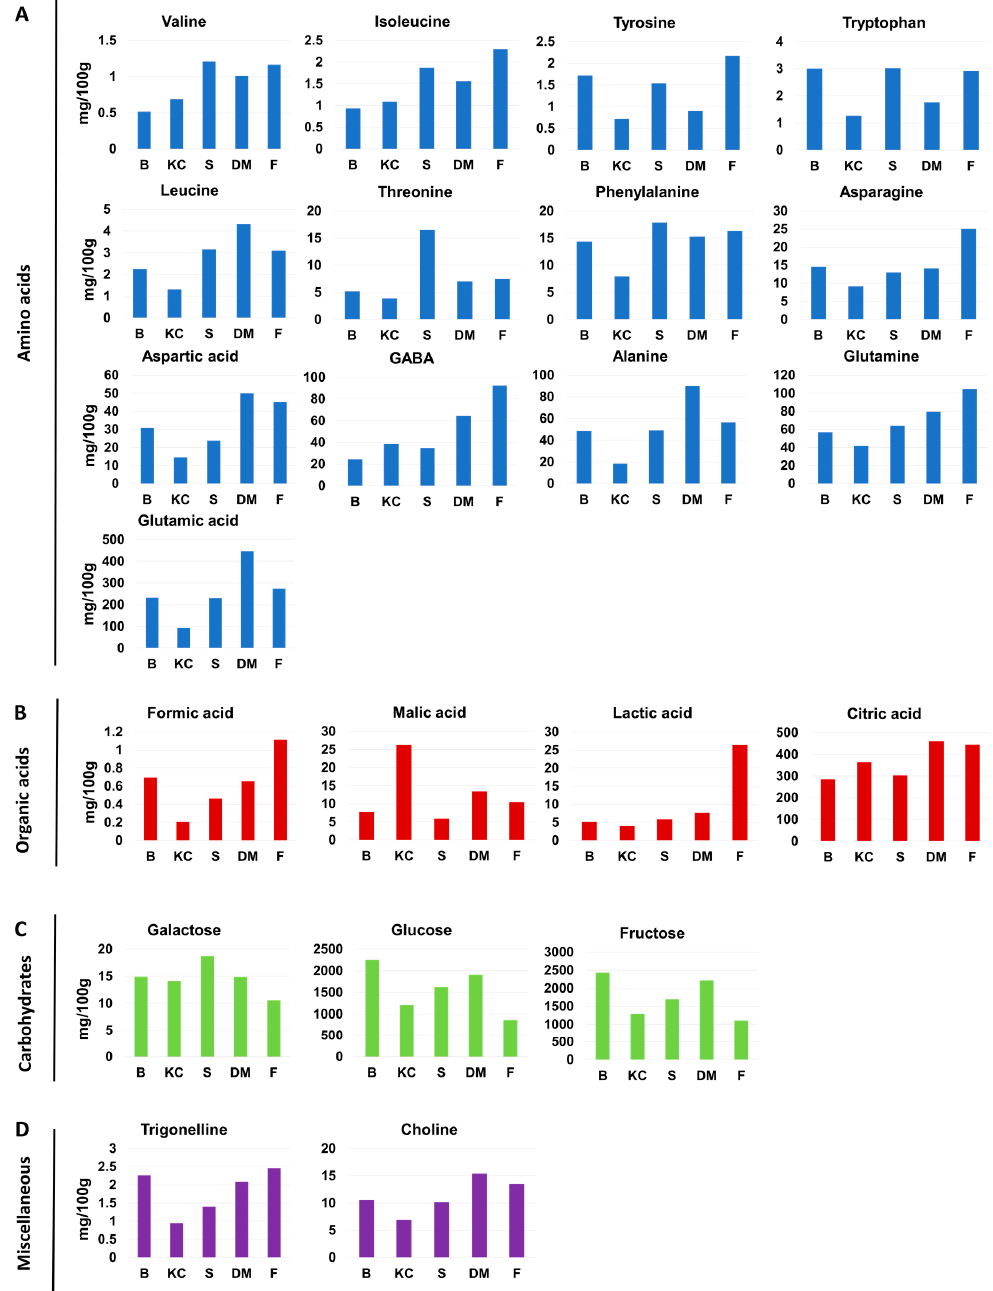
Figure 2. Histograms comparing the level of metabolites present in tomato hydroalcoholic extracts from the five investigated cultivars: ( A ) Amino acids; ( B ) Organic acids; ( C ) Carbohydrates; ( D ) Miscellaneous (B: Bamano, KC: King Creole, S: Sugarland, DM: DulceMiel, F: Fiaschetta). Data shown are expressed as mg/100 g FW.